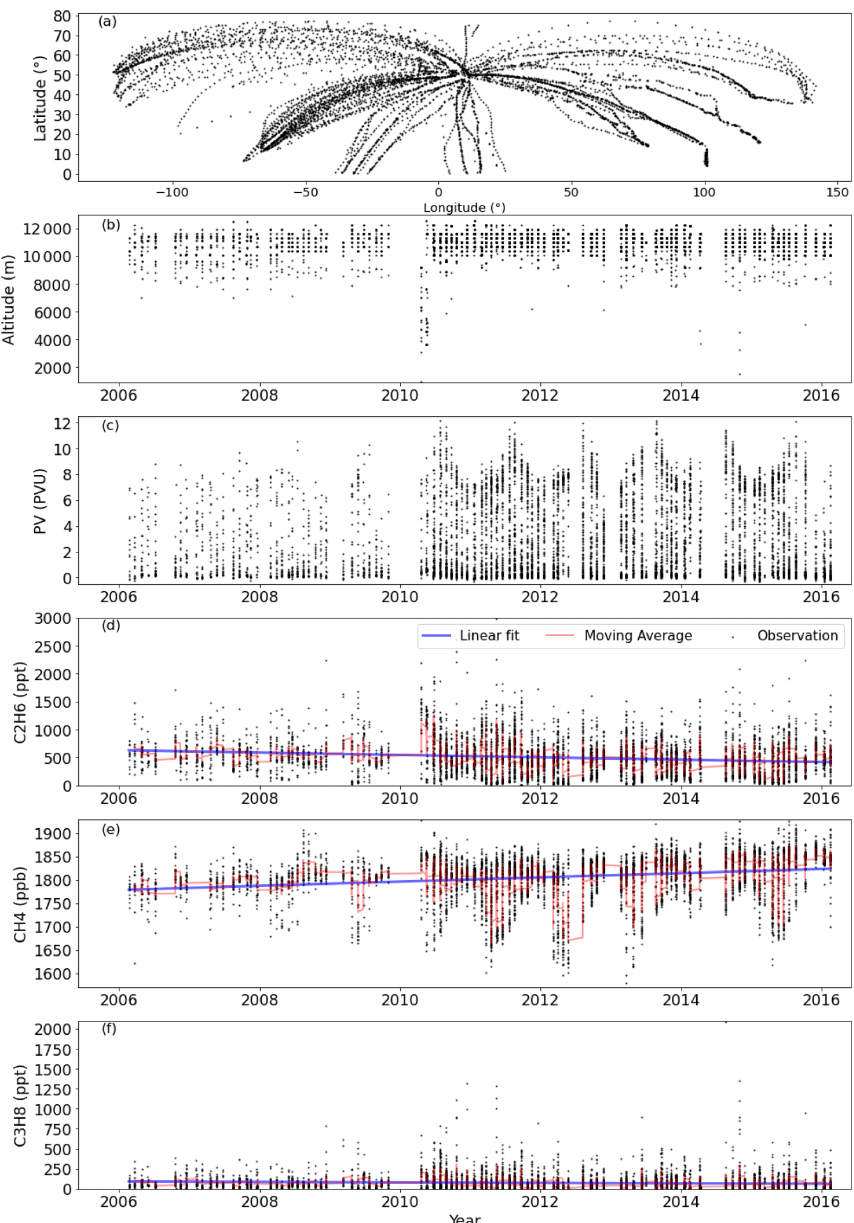
Figure 1. Data overview of (a) geographical distribution, (b) altitude, (c) potential vorticity (PV), mole fractions of (d) ethane, (e) methane and (f)